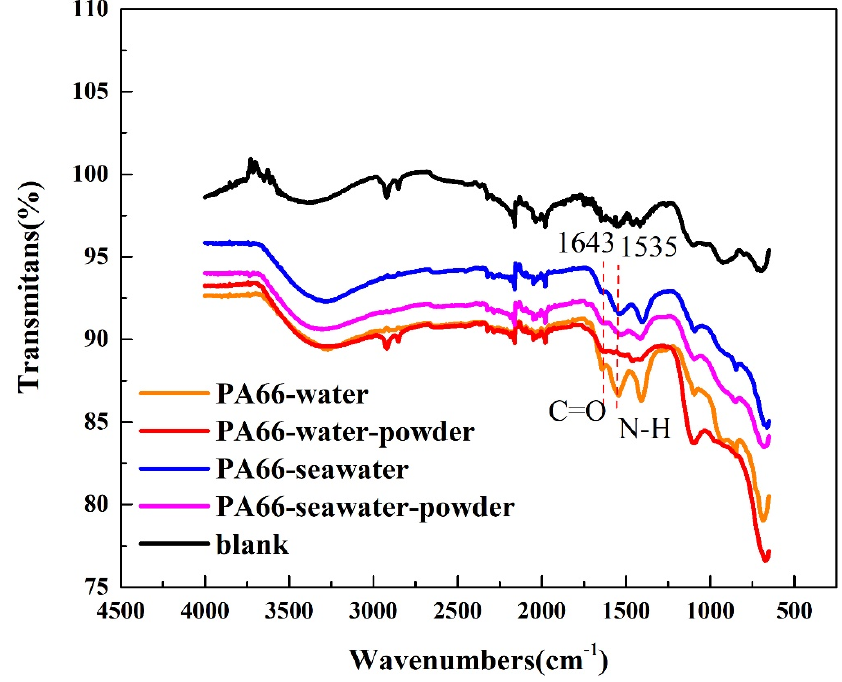
Figure 13. Infrared spectrogram of the aluminum surface of grinding components.